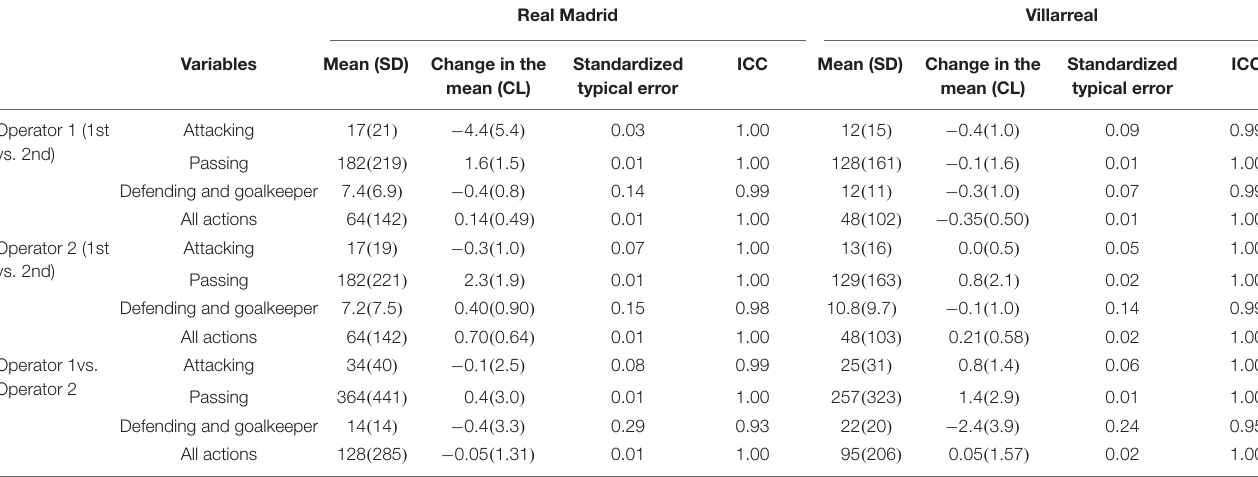
TABLE 5 | Intra-operator and inter-operator reliability of match actions coded within two data collection.